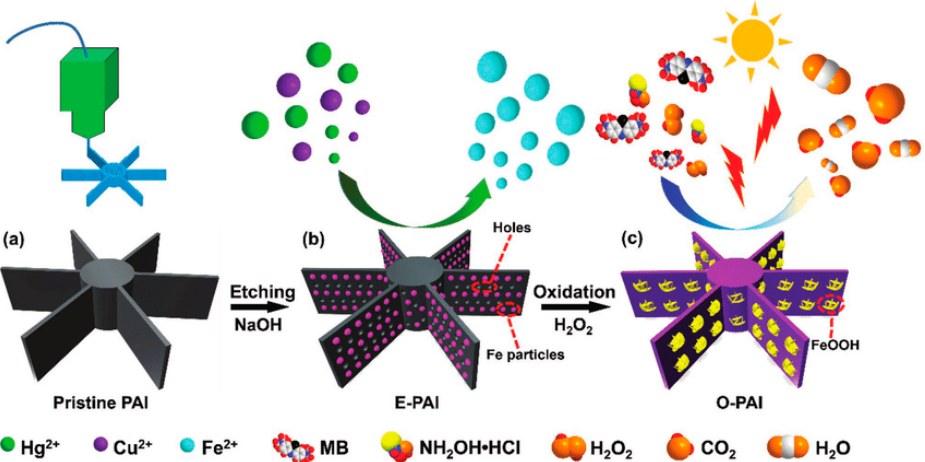
Figure 4. Schematic representation 3D printed AI preparation for water treatment. ( a ) Pristine PAI; ( b ) E-PAI (metal ions removal); ( c ) Fenton reaction catalyzer O-PAI [124,126]. Reproduced with